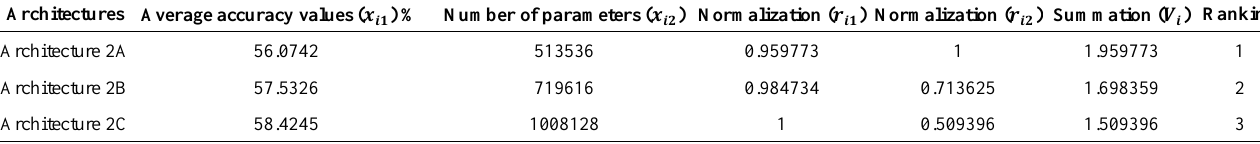
Table 5. Normalization results for the second stage of the DEAP